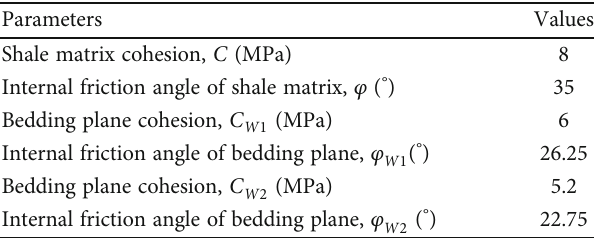
Table 7: Parameters used in the wellbore stability analysis considering the strength degradation due to the chemical e ff